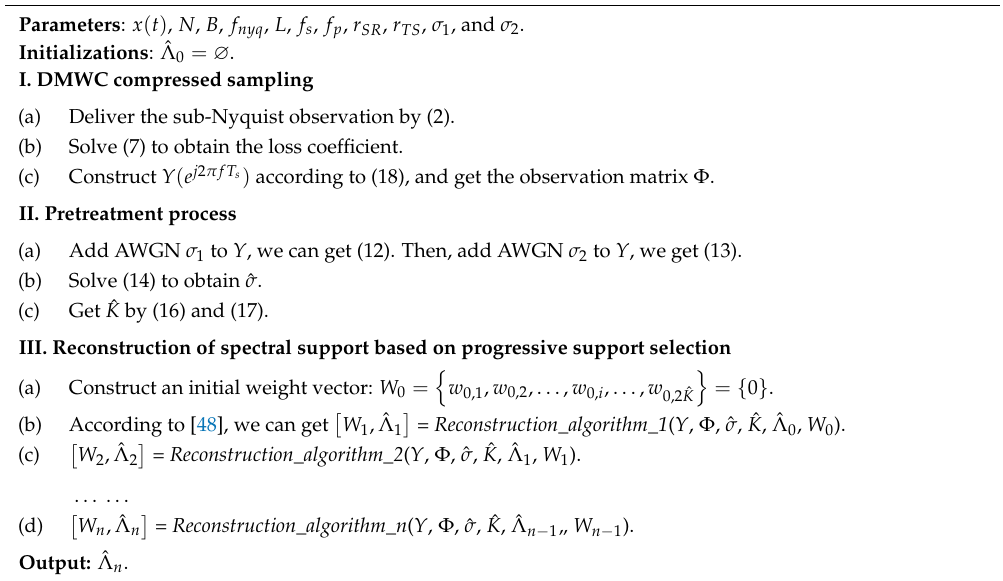
Algorithm 1. The description of the PSS-SaDMWC scheme.